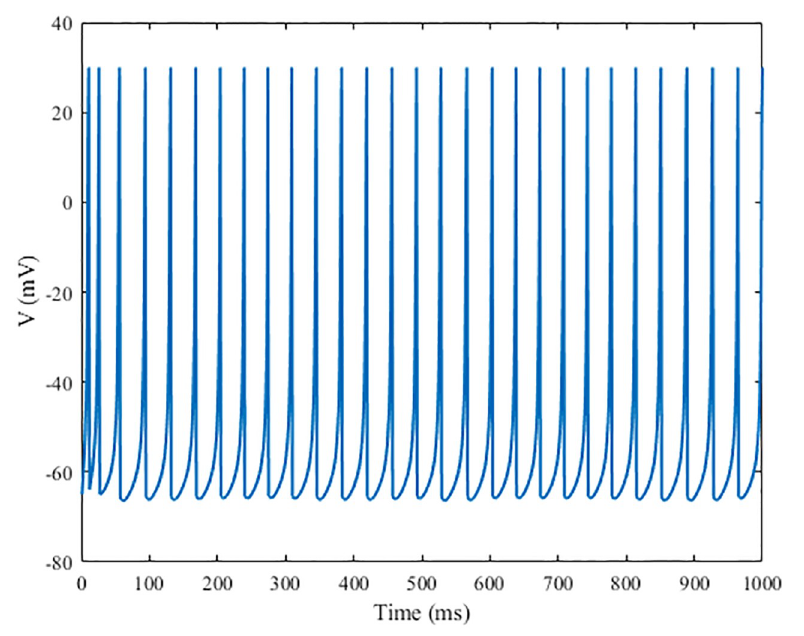
Fig 2. Firing patterns of the low-threshold spiking mode of the Izhikevich neurons. The parameters of the inhibitory neuron are: a = 0.02, b = 0.25, c = − 65, and d = 2.